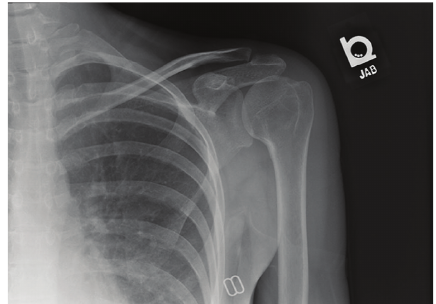
Figure 2: Anteroposterior radiograph at 6 months